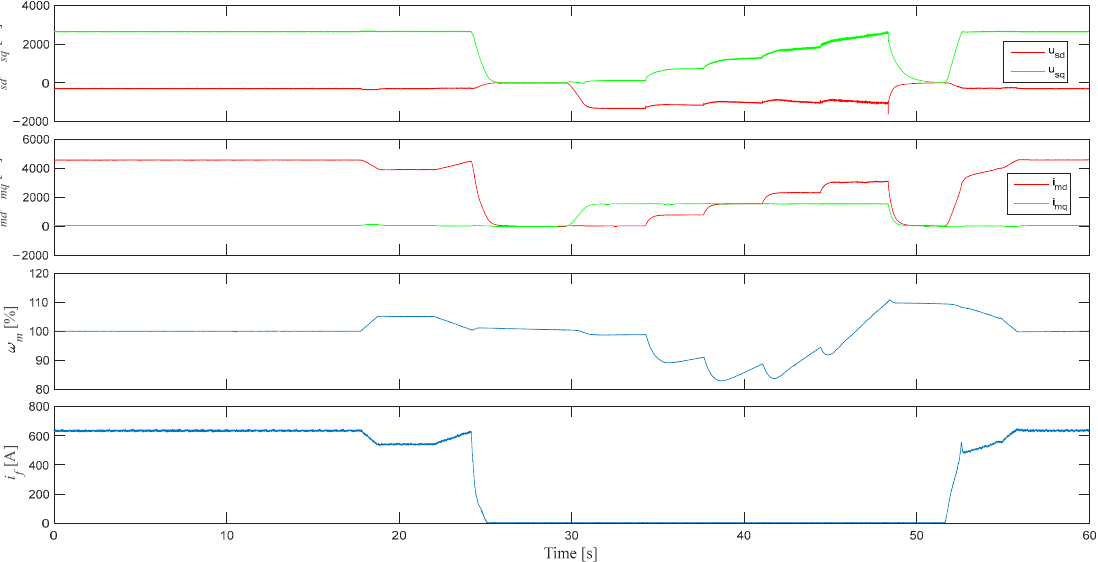
Figure 13. Waveforms of the considered machine during experimental verification of the method.